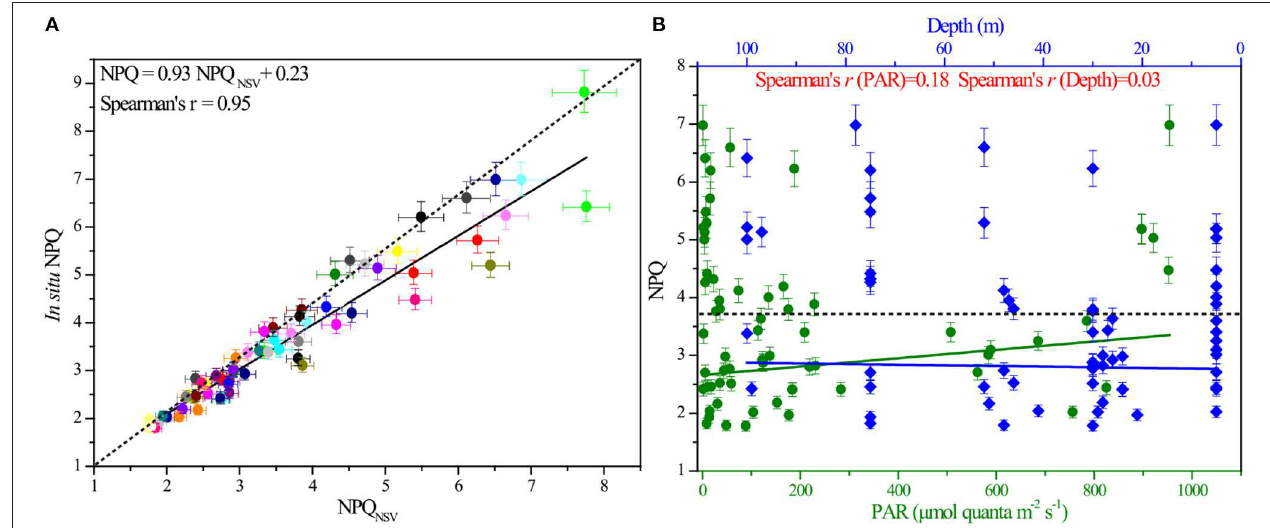
FIGURE 3 | The correlation between in situ NPQ and NPQ NSV , as well as the responses of in situ NPQ to light and depth. (A) In situ NPQ derived from FRRF measurements plotted against NPQ NSV calculated by fluorescence parameters of the same water (Spearman’s rank correlation coefficient S = 0.95, n = 72). (B) Responses of NPQ to changes in light and depth over the course of the in situ experiment ( S PAR = 0.18, S depth = 0.03). NPQ was derived from the in situ FRRF measurements and is unitless. The dashed line indicates the average value of